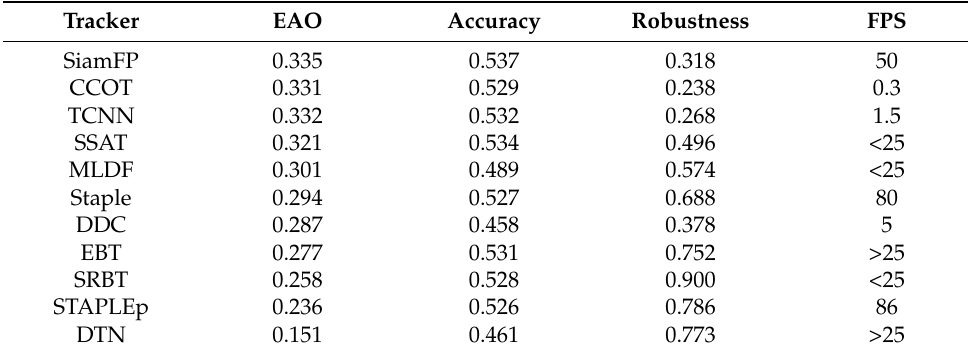
Table 3. Tracking Results on VOT Dataset.